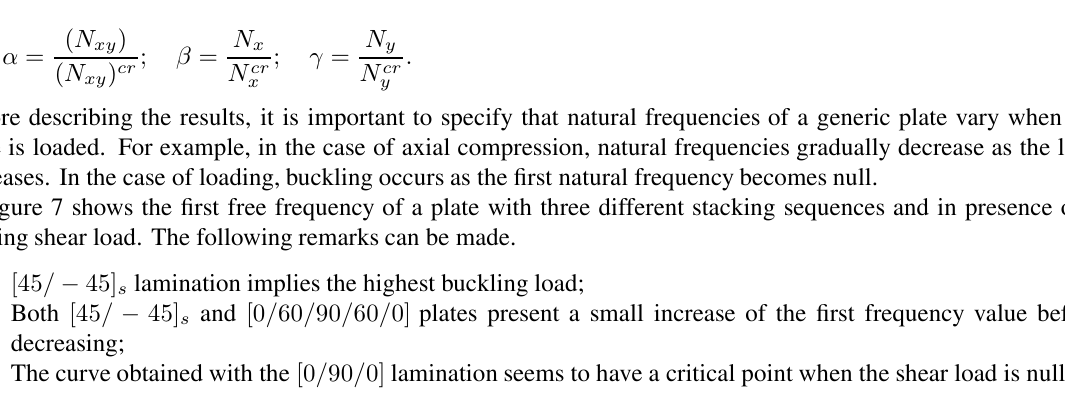
Fig. 8. M = [11], PM = Presented Model. UAC (left) and BAC (right) for a SSSS plate. PLATE-41, Mesh 10 × 10 , a/h = 5